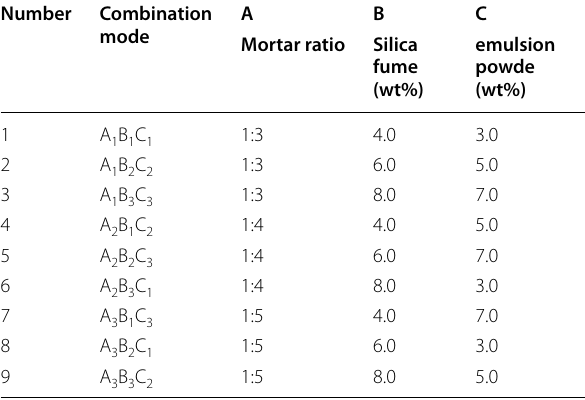
Table 7 Mix proportion combination design table of